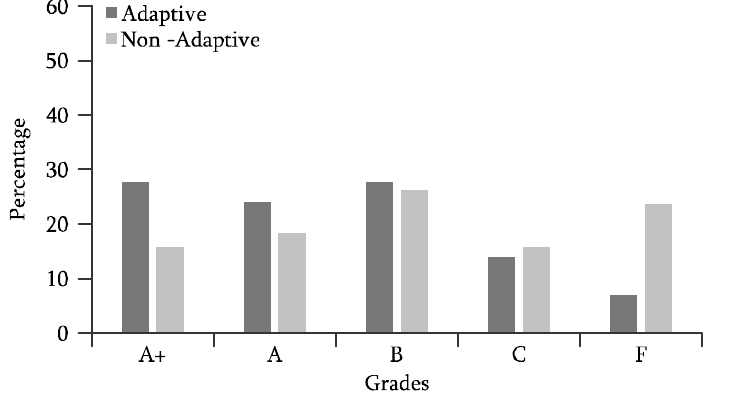
FIG. 8. RESULT COMPARISON FOR VISUAL BASIC